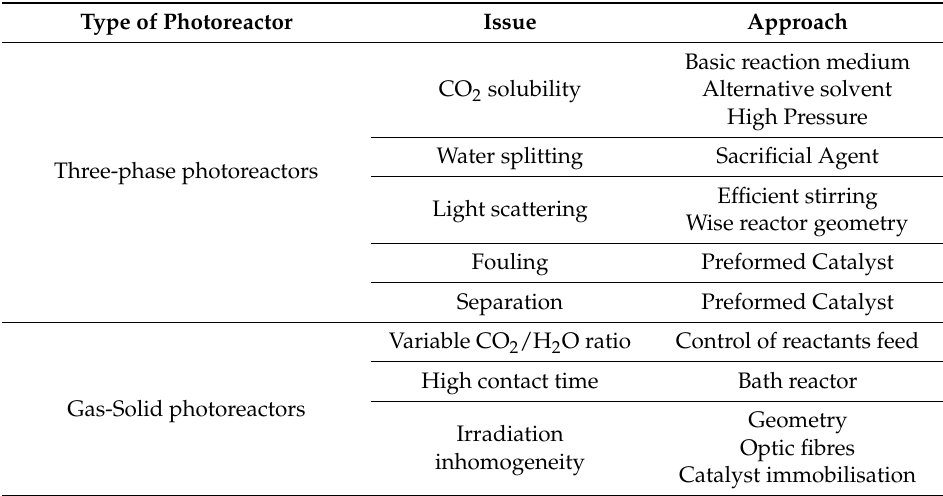
Table 3. Summary of features to consider in CO 2 photoreactor